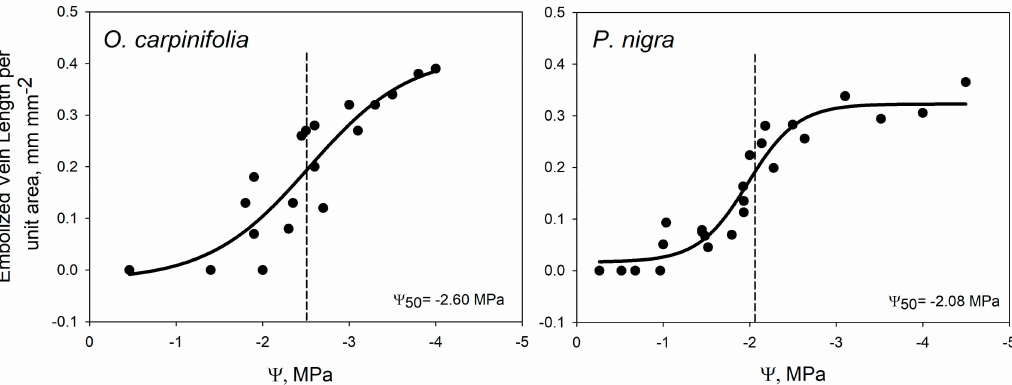
Figure 3. Vulnerability curves showing the embolized vein length per unit area as a function of leaf water potential, as measured in Ostrya carpinifolia ( left ) and Populus nigra ( right ). Values of leaf water potential inducing 50% embolism ( Ψ 50 ) are also reported (dashed line and insert in the